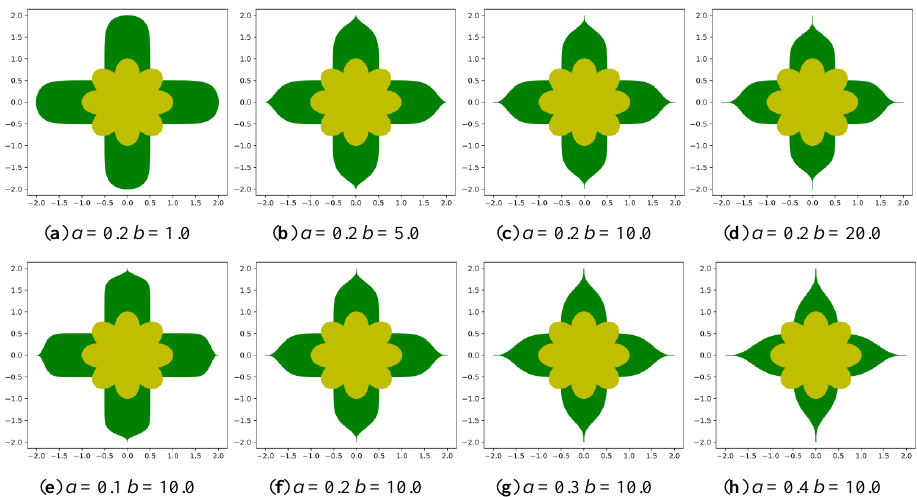
Figure 5. Different basic flower patterns generated by setting parameters a and b.